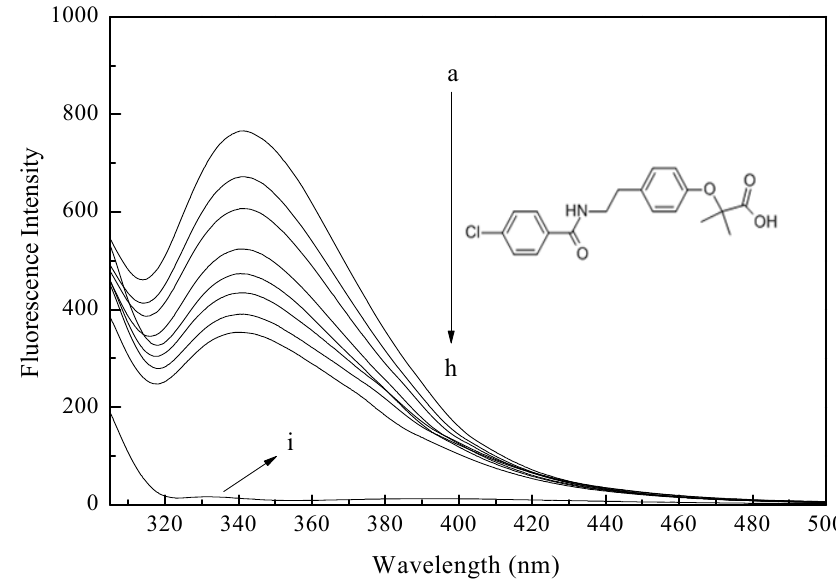
Figure 1. Effect of BZF on the fluorescence emission spectra of